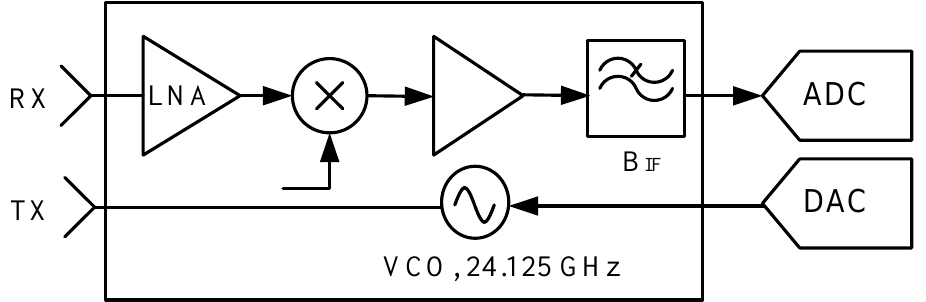
Figure 1. Linear Frequency Modulated Continuous Wave (LFM-CW) low-cost radar sensor.